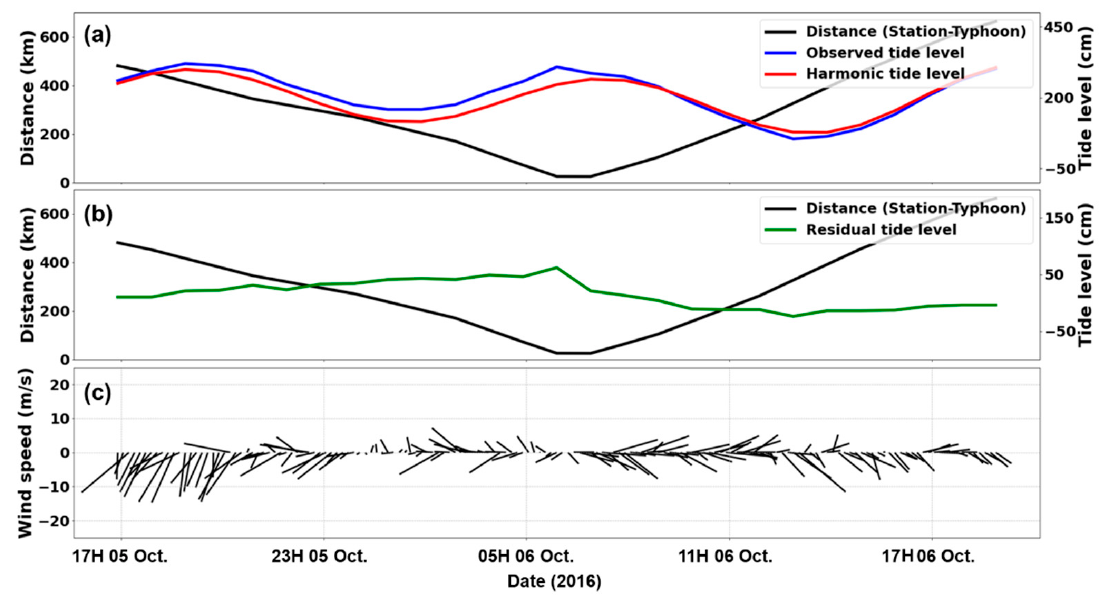
Figure 12. Time-series of observational data from Geomundo tidal station during Typhoon Kong-Rey. ( a ) Astronomical tide, ( b ) residual tide level, and ( c ) wind components, where direction and length represent wind direction and speed, respectively.